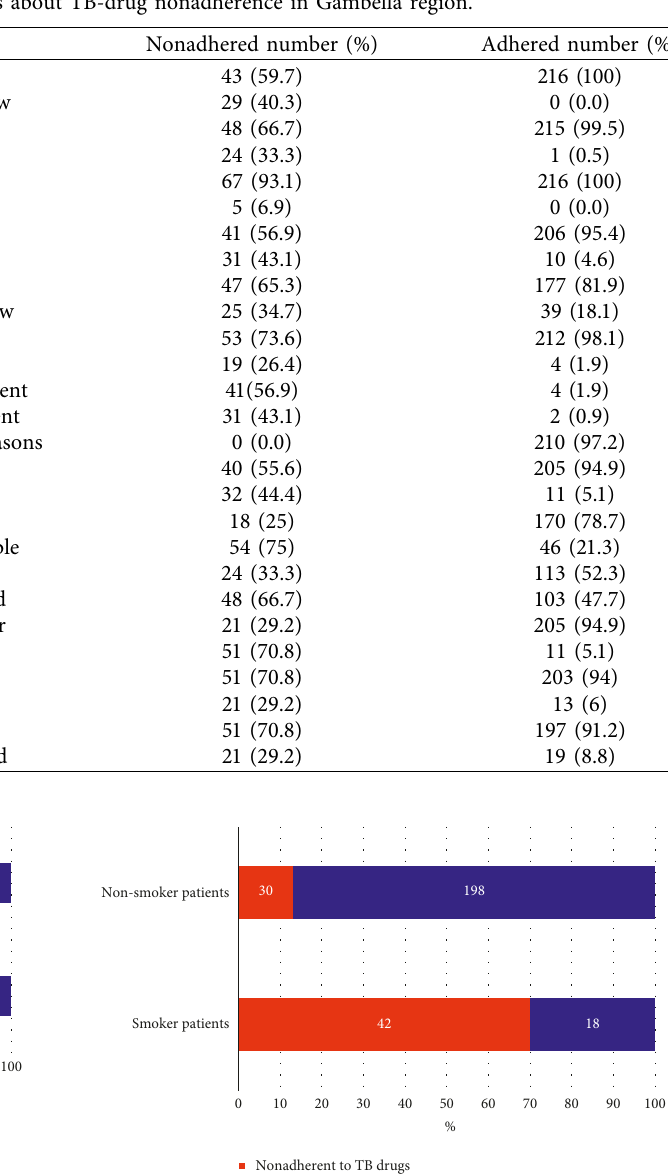
Table 3: TB patient behavioral factors about TB-drug nonadherence in Gambella region.